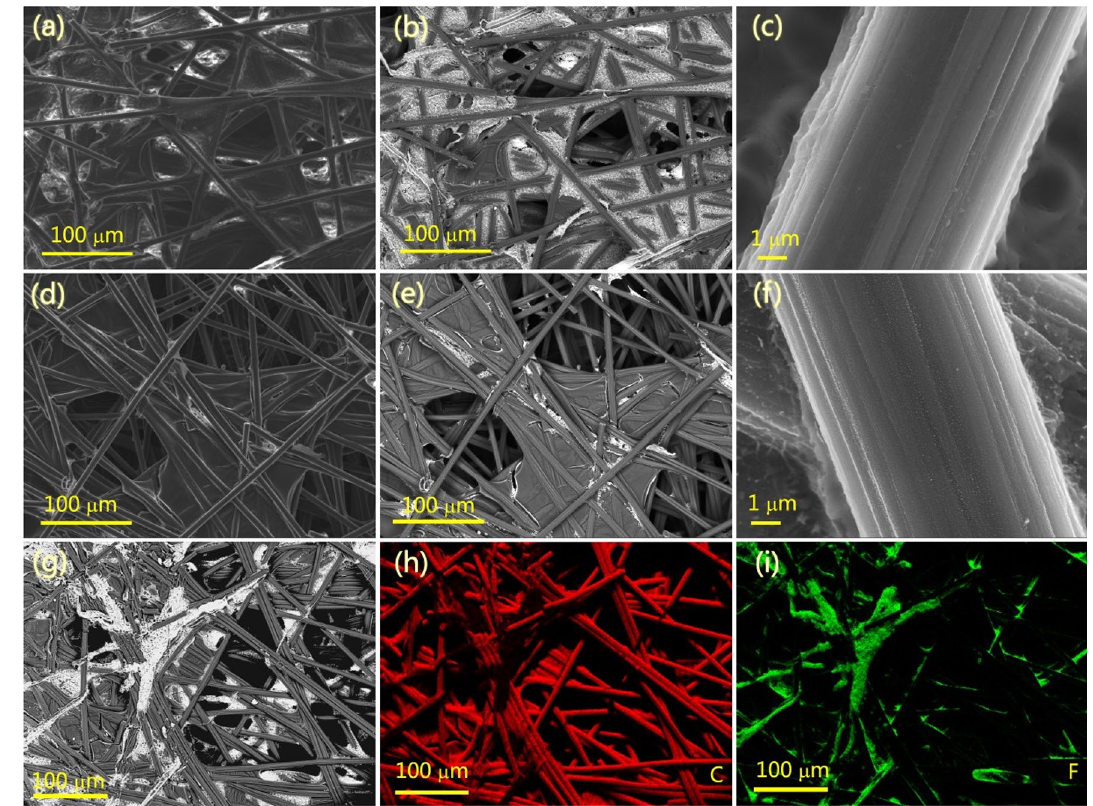
Fig. 3 a Low magnification secondary electron image, b low mag- nification back-scattered electron image and c high resolution SEM images of the original CP. d , e and f are the corresponding images of